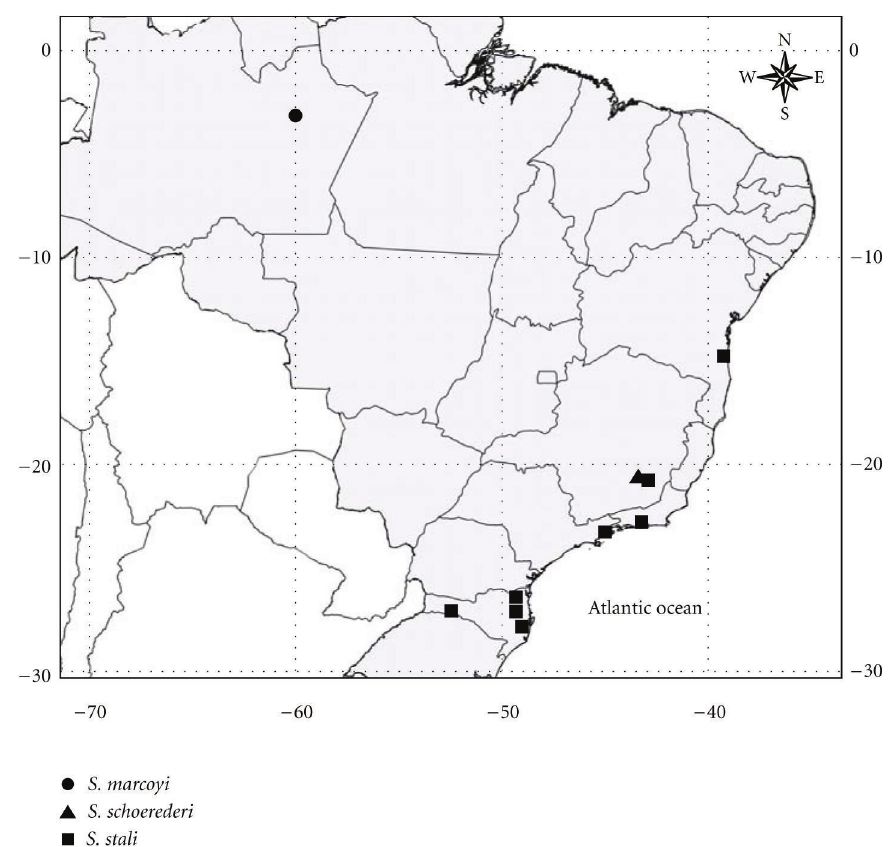
Figure 4: Distribution map for the neotropical species of Sphinctomyrmex